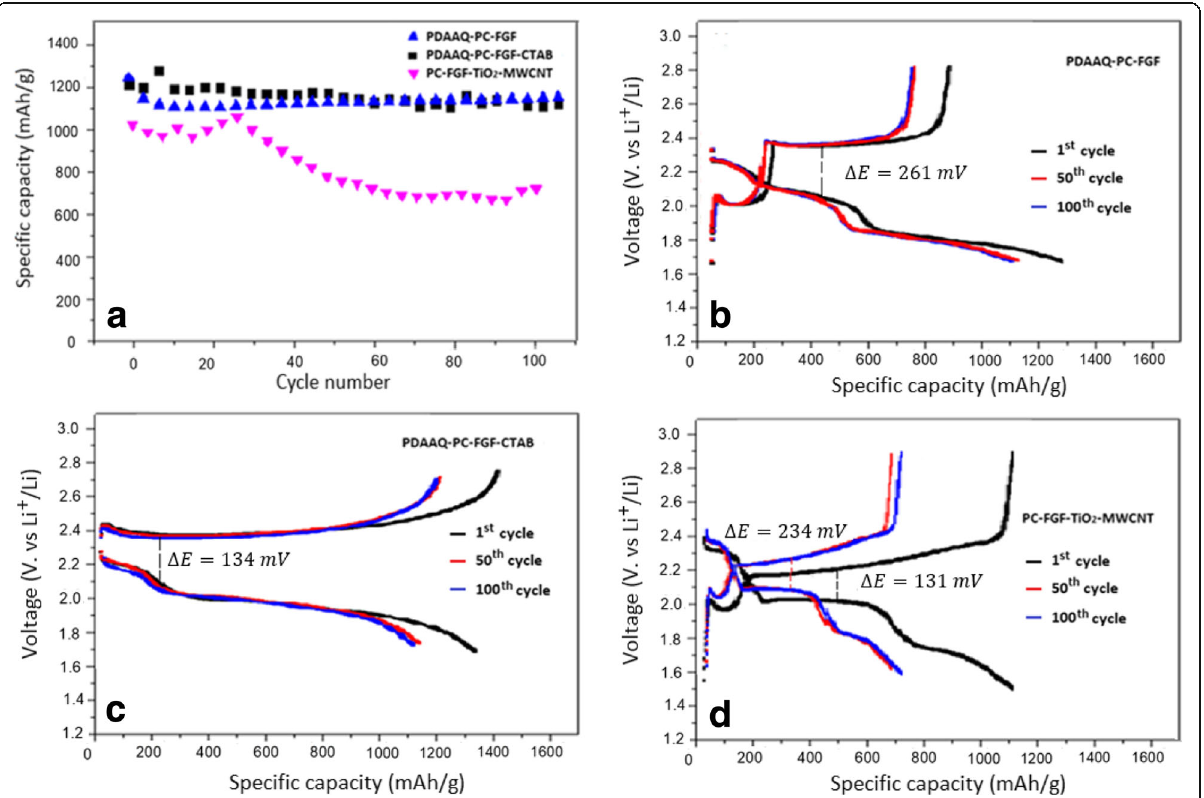
Fig. 4 a Cycling performance of Li-S cells with TiO 2 /PC-FGF/S cathode and three different coated separators at current density of 0.5 C. b Galvanostatic charge/discharge profiles for the 1st, 5th, 100th cycles of Li-S cells with PDAAQ/PC-FGF, c PDAAQ/PC-FGF/CTAB, d PC-FGF/TiO 2 / MWCNT interlayers at 0.5 C with potential window of 1.5 – 3 V versus Li + /Li